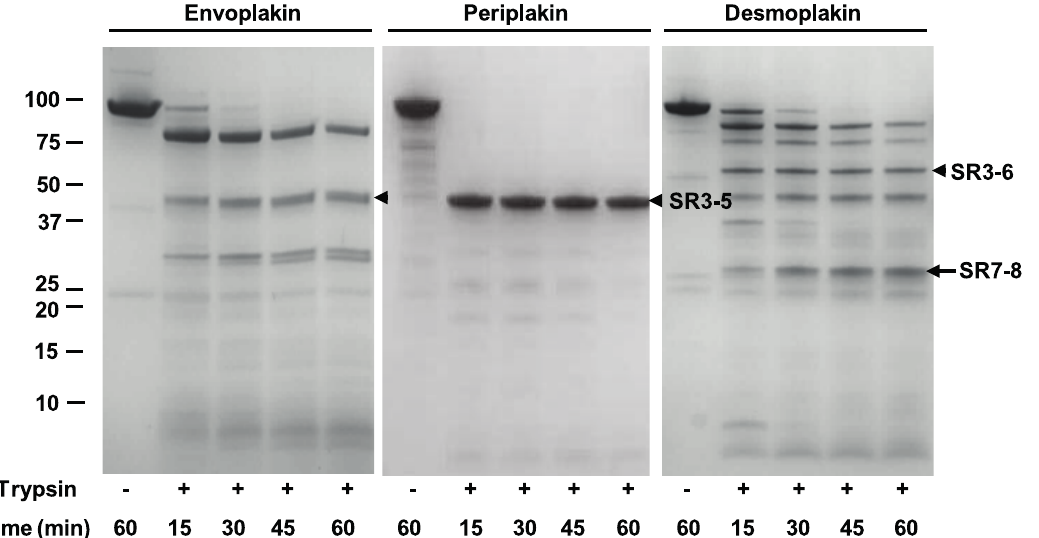
Figure 3. Limited proteolysis of the plakin domains of envoplakin, periplakin and desmoplakin. Proteins were purified and subjected to limited proteolytic digestion with trypsin (0.01 mg/ml) at 37 u C. Digestion of envoplakin and periplakin yielded major bands of 42 kDa, beginning with vector-derived GPLGS and native EVDP sequences, respectively, i.e. immediately N-terminal to SR3, and finishing within hinge or SR7 sequences. These bands closely match the expected sizes of the SR3-5 domains, ie. 40.4 and 41.7, respectively, based on the alignment which infers their lack of SR6 modules. Similar cleavage patterns are found with endopeptidase GluC, and are consistent with mass spectrometry results with the protease resistant periplakin SR3-5 fragment (data not shown). Tryptic cleavage of desmoplakin occurred in the flexible hinge at Lys653 and yielded a larger 54 kDa fragment corresponding to SR3-6. This agrees with previous desmoplakin digestion experiments showing that trypsin and chymotrypsin cleave its plakin domain N-terminal to SR3’s a A helix at Lys167 and Tyr172, leaving a 55 kDa proteolytically resistant fragment that encompasses its SR3-SR6 sequence and is resolvable by X-ray crystallography [26]. Digestion of desmoplakin also yielded a 27 kDa SR7-8 protease resistant fragment, beginning with the sequence VIENTR. This fragment could also be expressed as a soluble domain that yielded dispersed NMR spectra indicative of a helical fold [21]. Comparably sized but less abundant fragments were obtained upon digestion of envoplakin and periplakin.